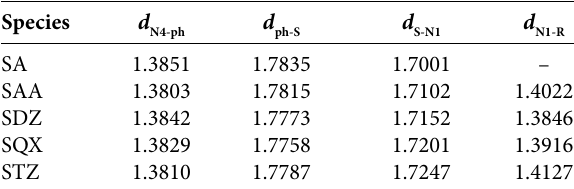
Table 2 . Some selected bond lengths (Å) for SA species in neutral state at the B3LYP/6-311++G(dip) level of theory. Species d